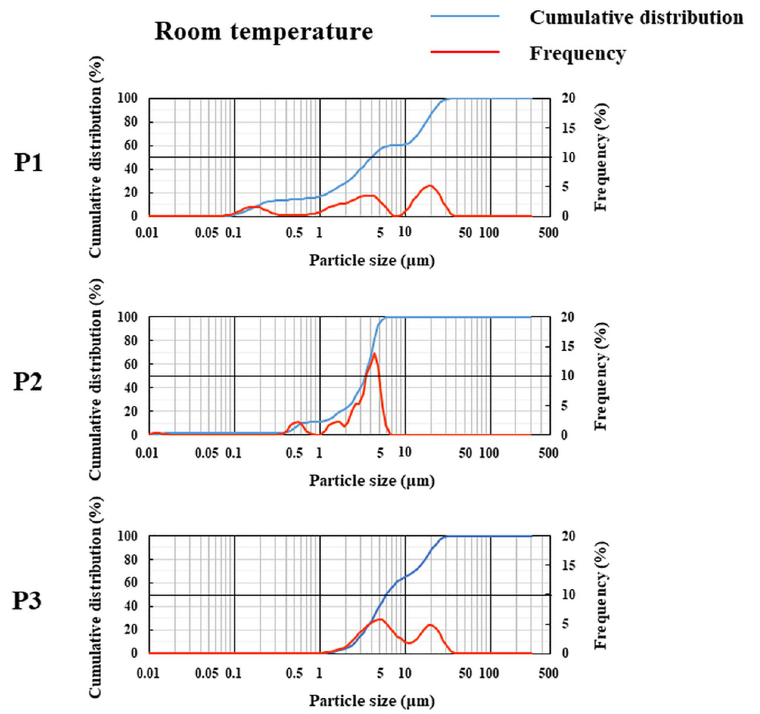
Fig 5. Particle size distribution and cumulative frequency for each formulation of 0.1% FLU ophthalmic suspensions. In the room temperature group, each formulation of 0.1% FLU ophthalmic suspension was stored at 10 ˚C for three months and subsequently maintained at room temperature for two months or left at room temperature for five months. Each panel represents the relative particle size distribution and cumulative frequency in three formulations of 0.1% FLU ophthalmic suspensions as measured on the laser diffraction particle size analyzer. P1; Original, P2; Generic A, P3; Generic B. All the images are representative of three independent experiments.